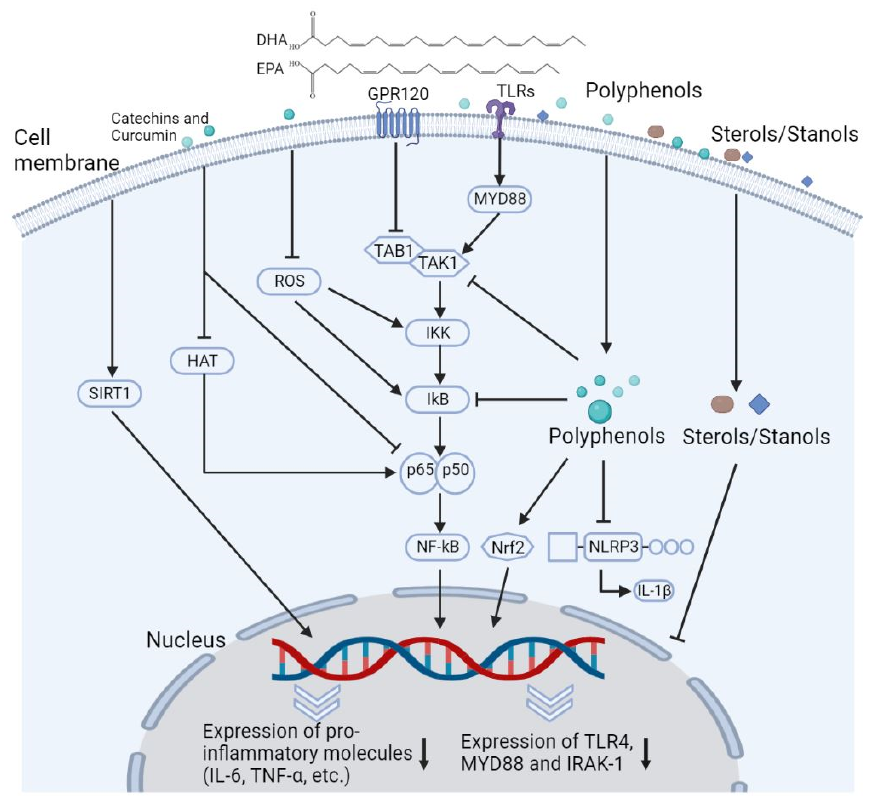
Figure 4. Possible effects of plant sterols/stanols, omega-3 fatty acids, and polyphenols, on cellular events in antigen presenting cells. Toll-like receptor (TLR) engagement triggers pro-inflammatory responses in macrophages and dendritic cells. Plant sterols/stanols inhibit gene expression of TLR4, MyD88, and IL-1 receptor associated kinase (IRAK)-1. Eicosatetraenoic acid (EPA) and docosa- hexaenoic acid (DHA) bind G protein-coupled receptor (GPCR) 120. GPR120 engagement inhibits TLR4-induced association of TGF- β -activated kinase 1 (TAK1)-binding protein 1 (TAB1) with TAK1, that block nuclear factor-kappa B (NF-kB)-mediated pathway. Polyphenols inhibit NF-kB-mediated pathways by inhibiting phosphorylation of I κ B kinase (IKK) and the degradation of inhibitor of NF- κ B (I κ B) and altering activity of enzymes including Sirtuin 1 (SIRT1) and histone acetyltransferase (HAT). Polyphenols also inhibit formation of NLR Family Pyrin Domain Containing 3 (NLRP3) inflammasome. Polyphenols are ligands of nuclear factor erythroid 2-related factor 2 (Nrf2), that negatively regulates gene expression of pro-inflammatory